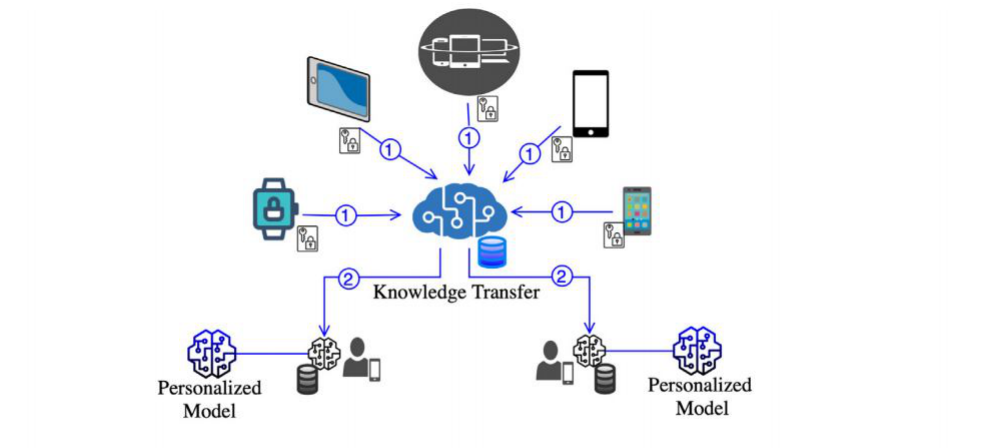
Figure 5. Federated transfer learning